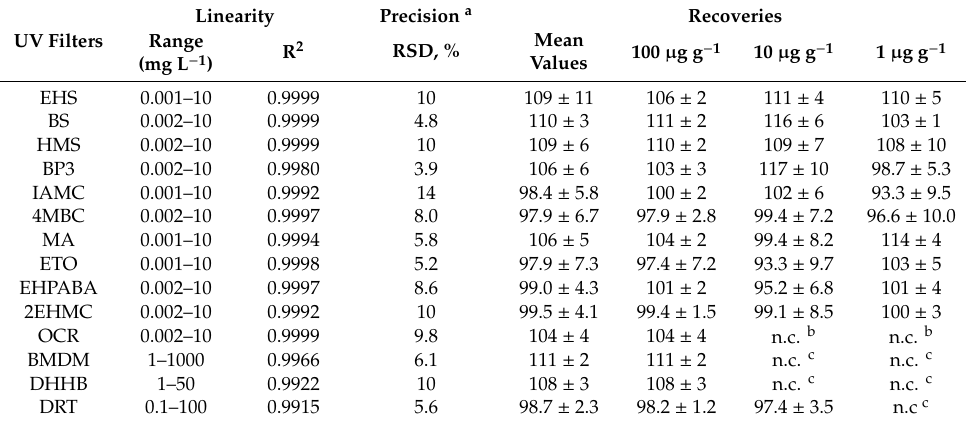
Table 4. µ -MSPD-gas-chromatography tandem mass spectrometry (GC–MS / MS) performance for the UV filters. Linearity, precision, and recovery